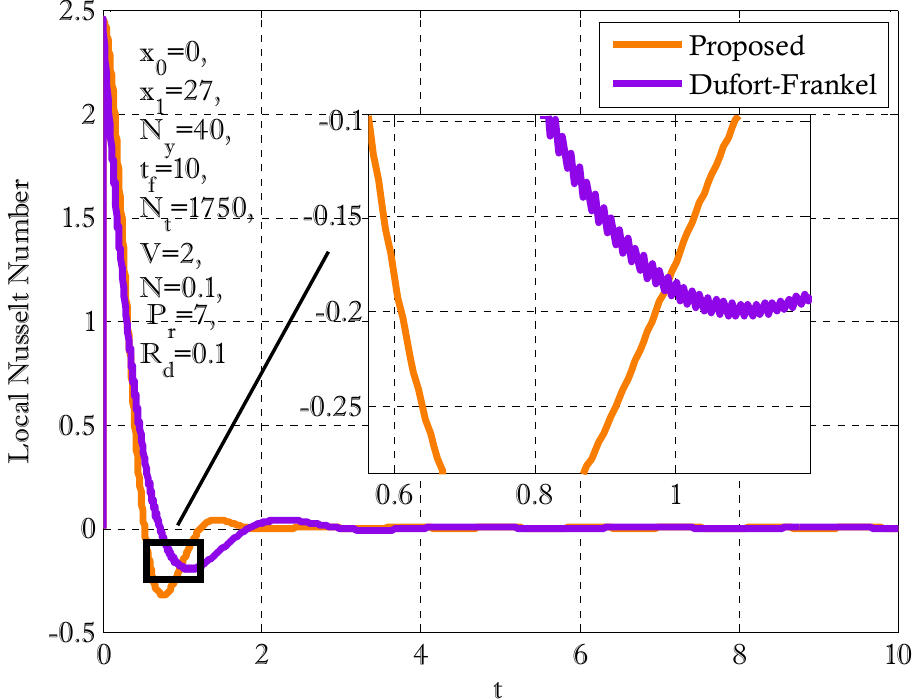
Figure 4. Comparison of the proposed scheme with the Dufort–Frankel method in finding the local Nusselt number through time.